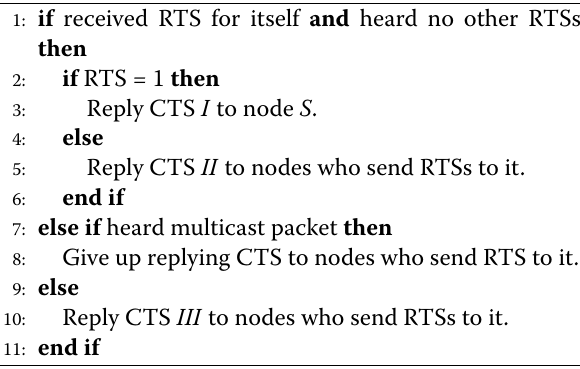
Algorithm 3 Operation process of node R